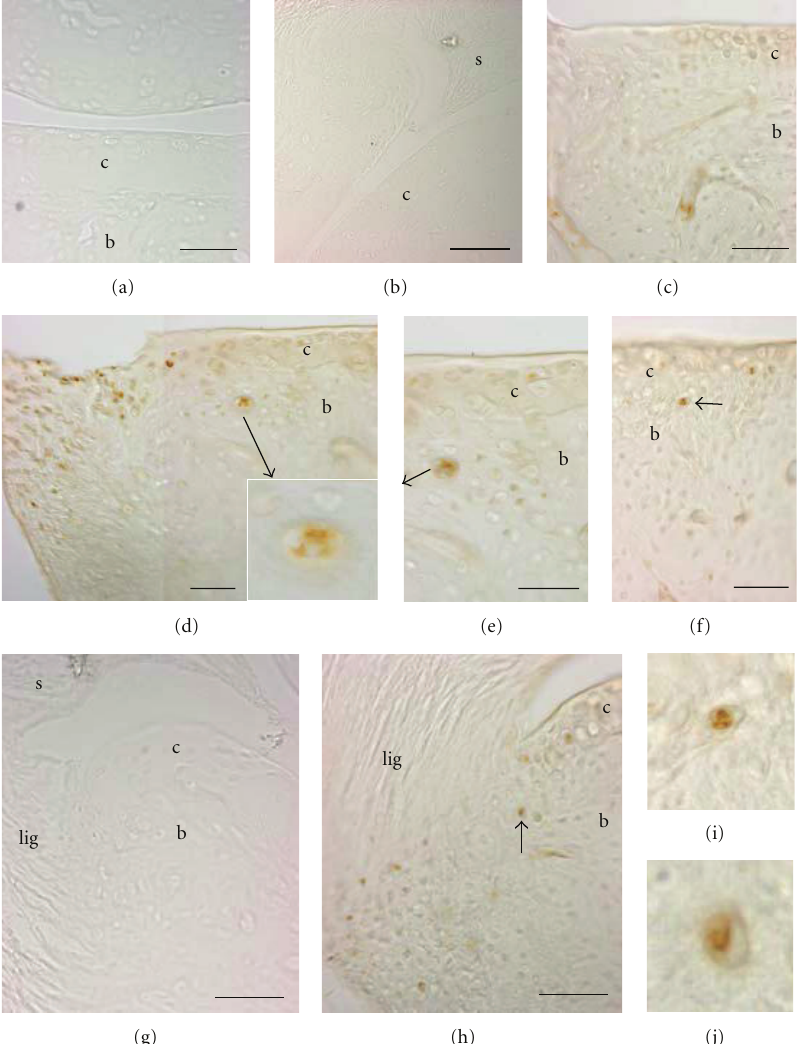
Figure 5: Distal radii and carpal bones stained with TUNEL (longitudinal sections of para ffi n embedded radius and carpal bones). (a)–(f) Micrographs showing distal radius articular cartilage (indicated as c, for cartilage) in (a) NC (normal control), (b) TR (trained control), and (c) HRHF + IBU (performed the high-repetition high-force task for 12 weeks and received ibuprofen treatment daily in last 8 weeks), (d)-(e) HRHF rat (12 weeks HRHF rat with no treatment). (d) is a lower-power photo showing medial edge of radius and increased TUNEL stained cells at that edge as well as stained cells in adjacent articular cartilage. Inset shows higher-power image of indicated cell. (e) is a higher-power photo of same section shown in (d). (f) shows the radial articular cartilage from a di ff erent rat than shown in (d) and (e). (g) Image showing the lateral edge of the radius of an NC rat at the site of the attachment of the radiocarpal ligament. (h) Image showing the lateral edge of the radius of an HRHF rat at the site of the attachment of the radiocarpal ligament. (i) Higher-power photo of same cell as indicated in (f) with an arrow. (j) Higher-power photo of same cell as indicated in (h) with an arrow. Scale bars = 50 μ m. b: bone, c: articular cartilage, lig: radiocarpal ligament, s: synovial